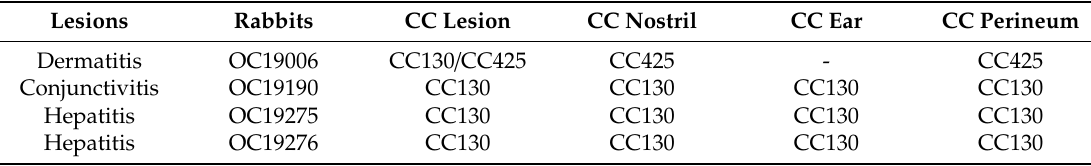
Table 5. Relation among the clonal complex (CC) isolates from rabbits with lesion / s and S. aureus